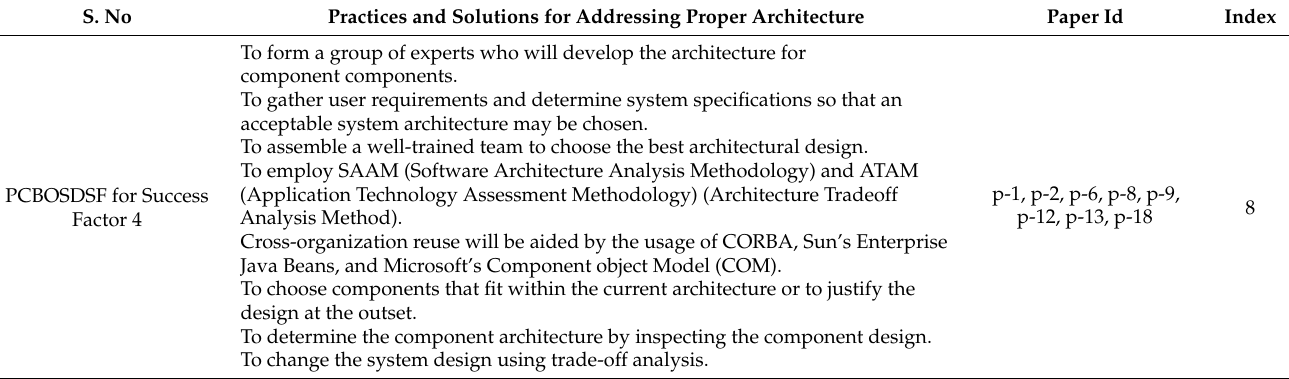
Table 8. CBOSDSF 4: Proper architecture.